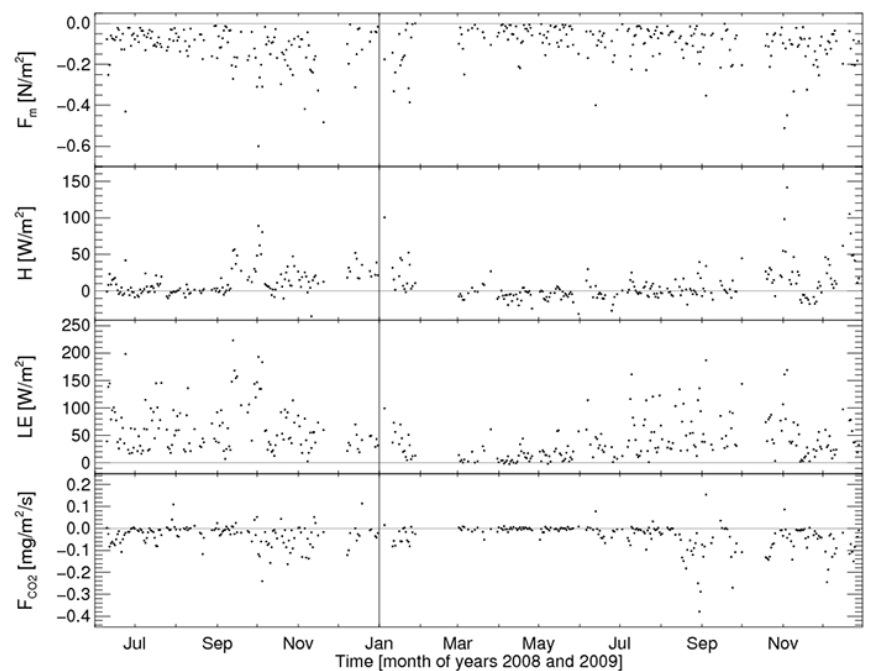
Figure 4. Daily means of momentum flux ( F m ), sensible and latent heat flux ( H and LE ), and CO 2 flux at a height of 13.8m from June 2008 to December